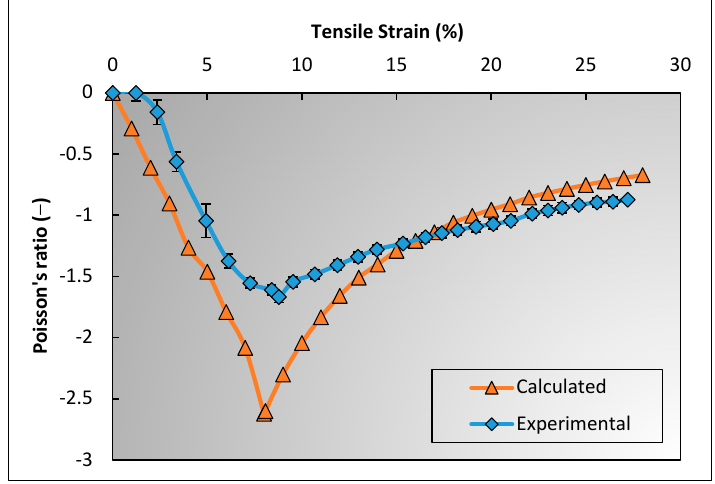
Figure 11. Comparison of calculated and experimental results of Poisson’s ratio against tensile strain.